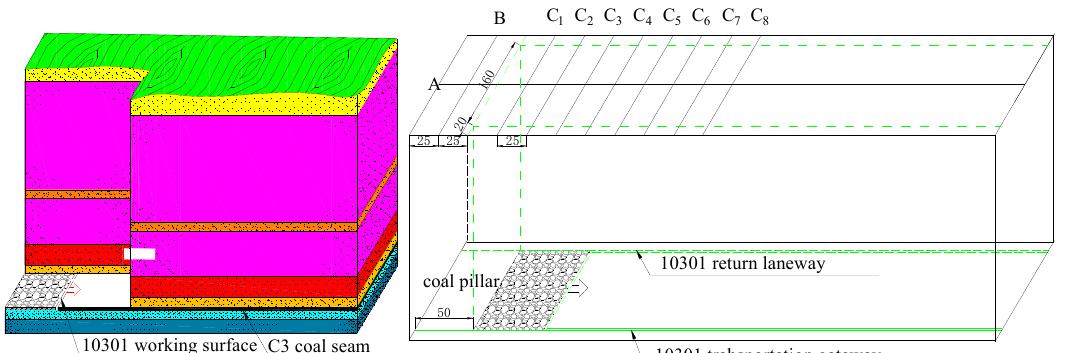
Figure 12. Layout of surface observation lines.